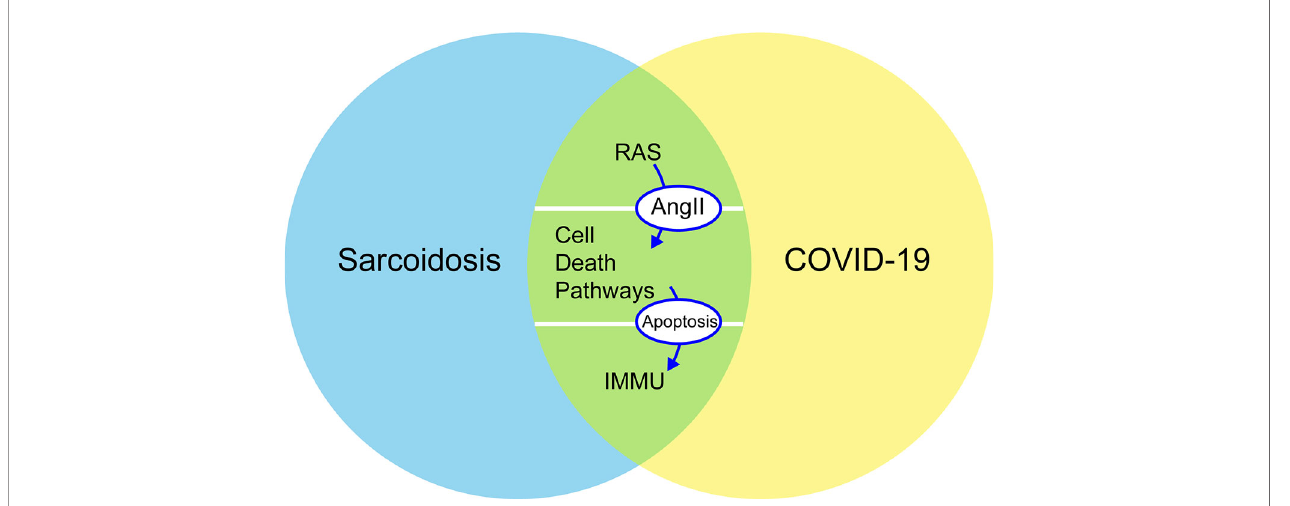
FIGURE 1 | Common mechanistic of COVID-19 and sarcoidosis including RAS, immune responses, and cellular death pathways (autophagy, apoptosis, and PD-1/ PD-L1 axis): increased concentrations of Ang II stimulate apoptosis and are negative regulators of autophagy. PD-1 increases the apoptosis of speci fi c T cells in lymph nodes and decreases the apoptosis of regulatory T cells. RAS, renin – angiotensin system; Ang II, angiotensin II; PD-1, programmed cell death 1; IMMU, immune